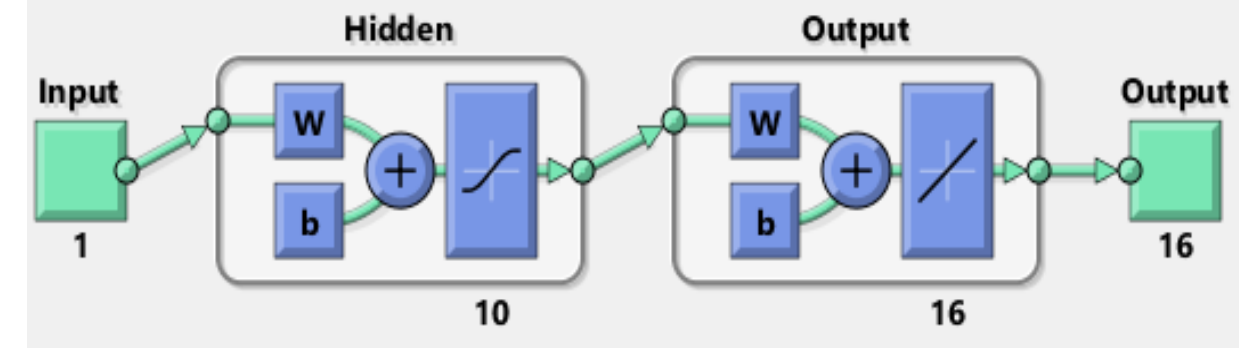
Figure 2. Design of Neural Network for HTM-BFN model.